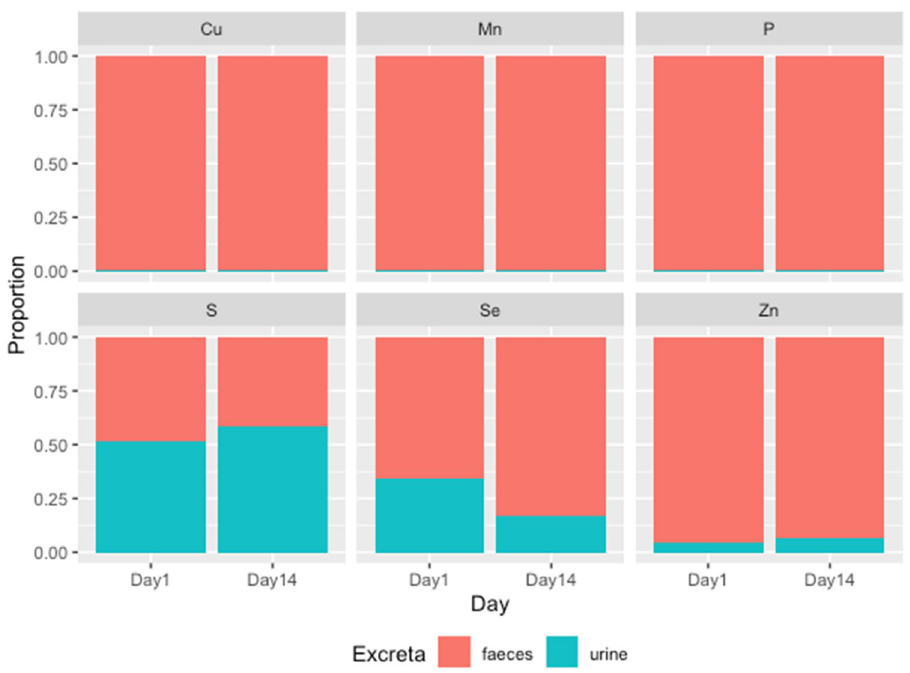
Figure 1. The proportion of mineral partitioning between urine and faeces of sheep (Charolais × Suffolk-Mule) on day 1 and day 14. Data are the average of the results across the four